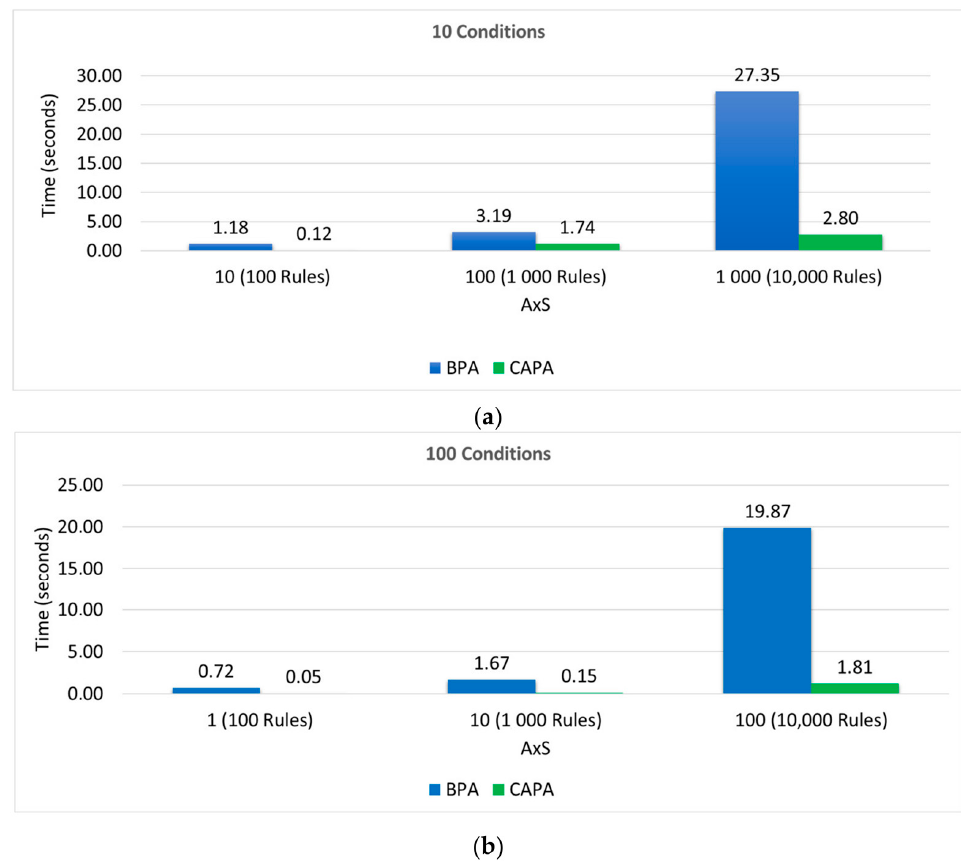
Figure 16. Total time required by the dependentResourceConflictDetection algorithm in CAPA and BPA: ( a ) 10 Conditions; ( b ) 100